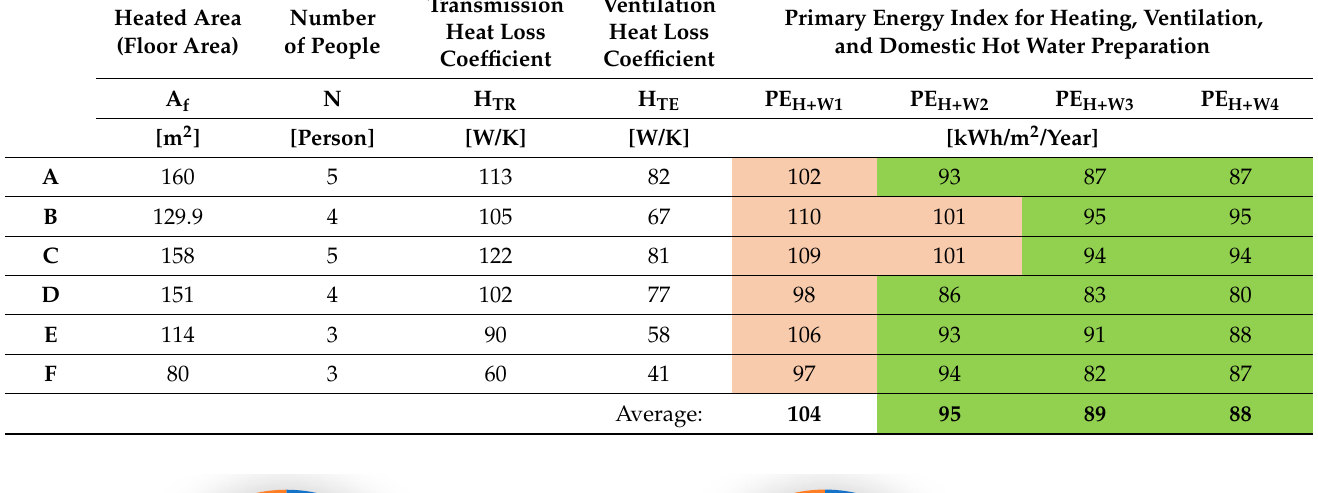
Table 9. Primary energy indicators obtained using various DHW consumption indicators for existing buildings.